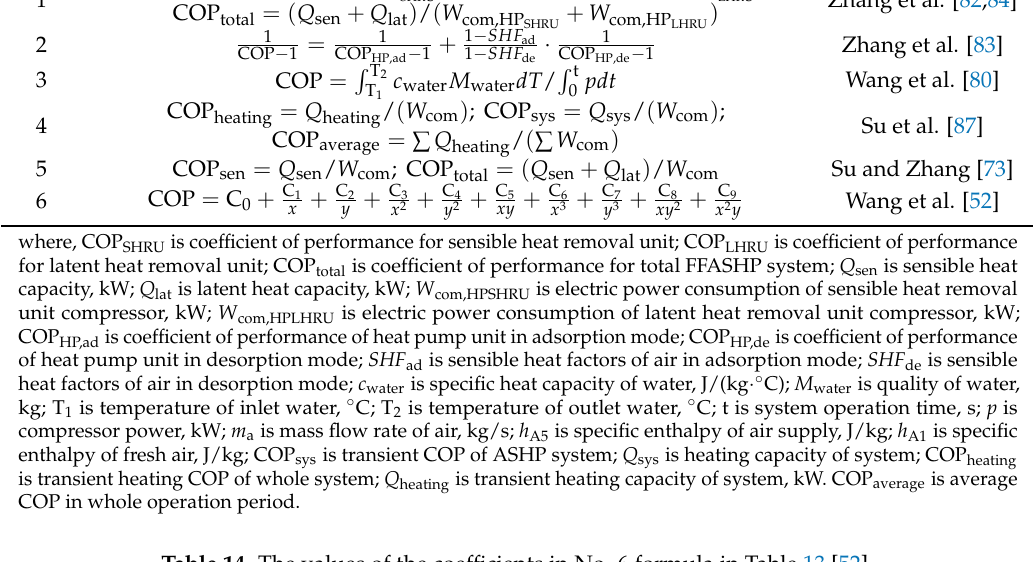
Table 14. The values of the coefficients in No. 6 formula in Table 13